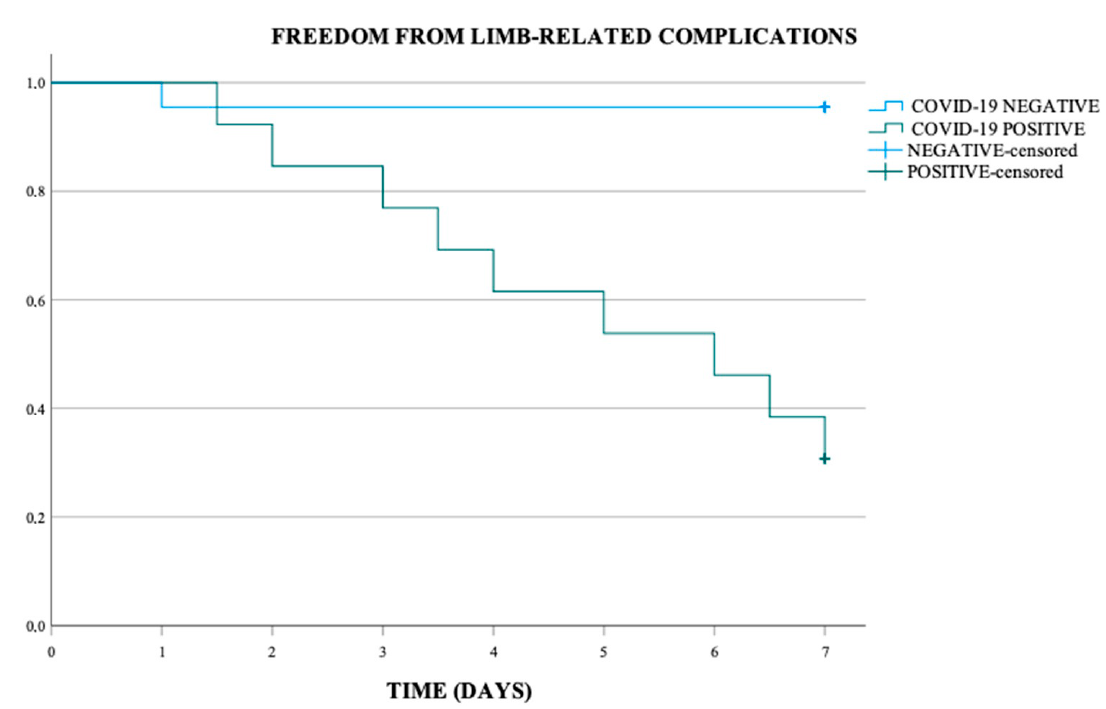
Scheme 1. Freedom from limb-related complications ( p -value < 0.001).